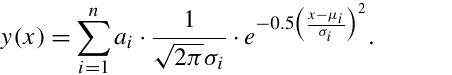
tify five different surface types including open water and four different ice types (nilas, gray sea ice, gray-white